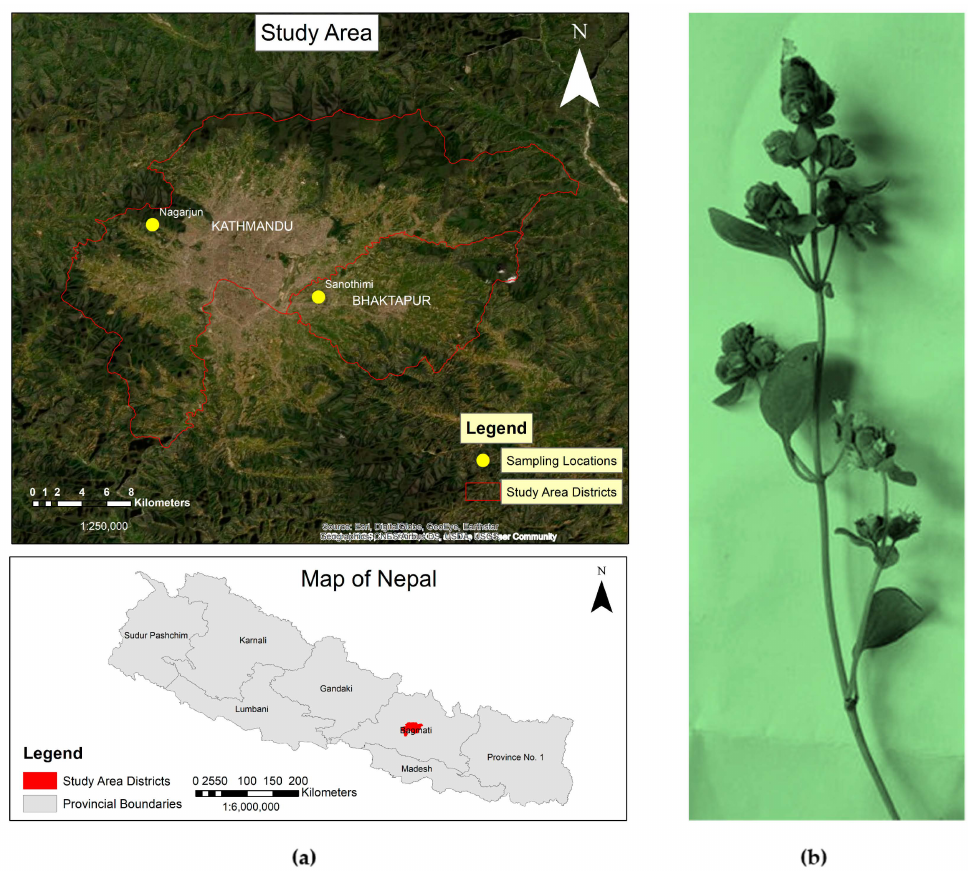
Figure 6. ( a ) The geographical location of majorana species collection sites; ( b ) a photograph of a twig of O. majorana